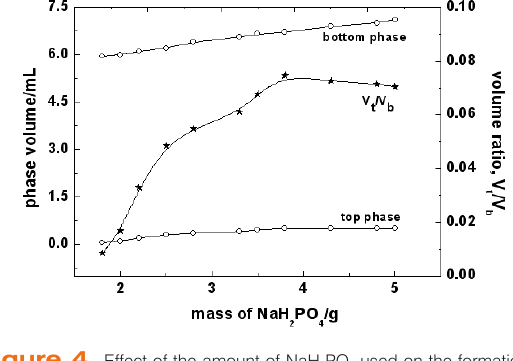
PO used on the formation 2 4 - NaH PO ILATPS and phase separation at 4 2 4